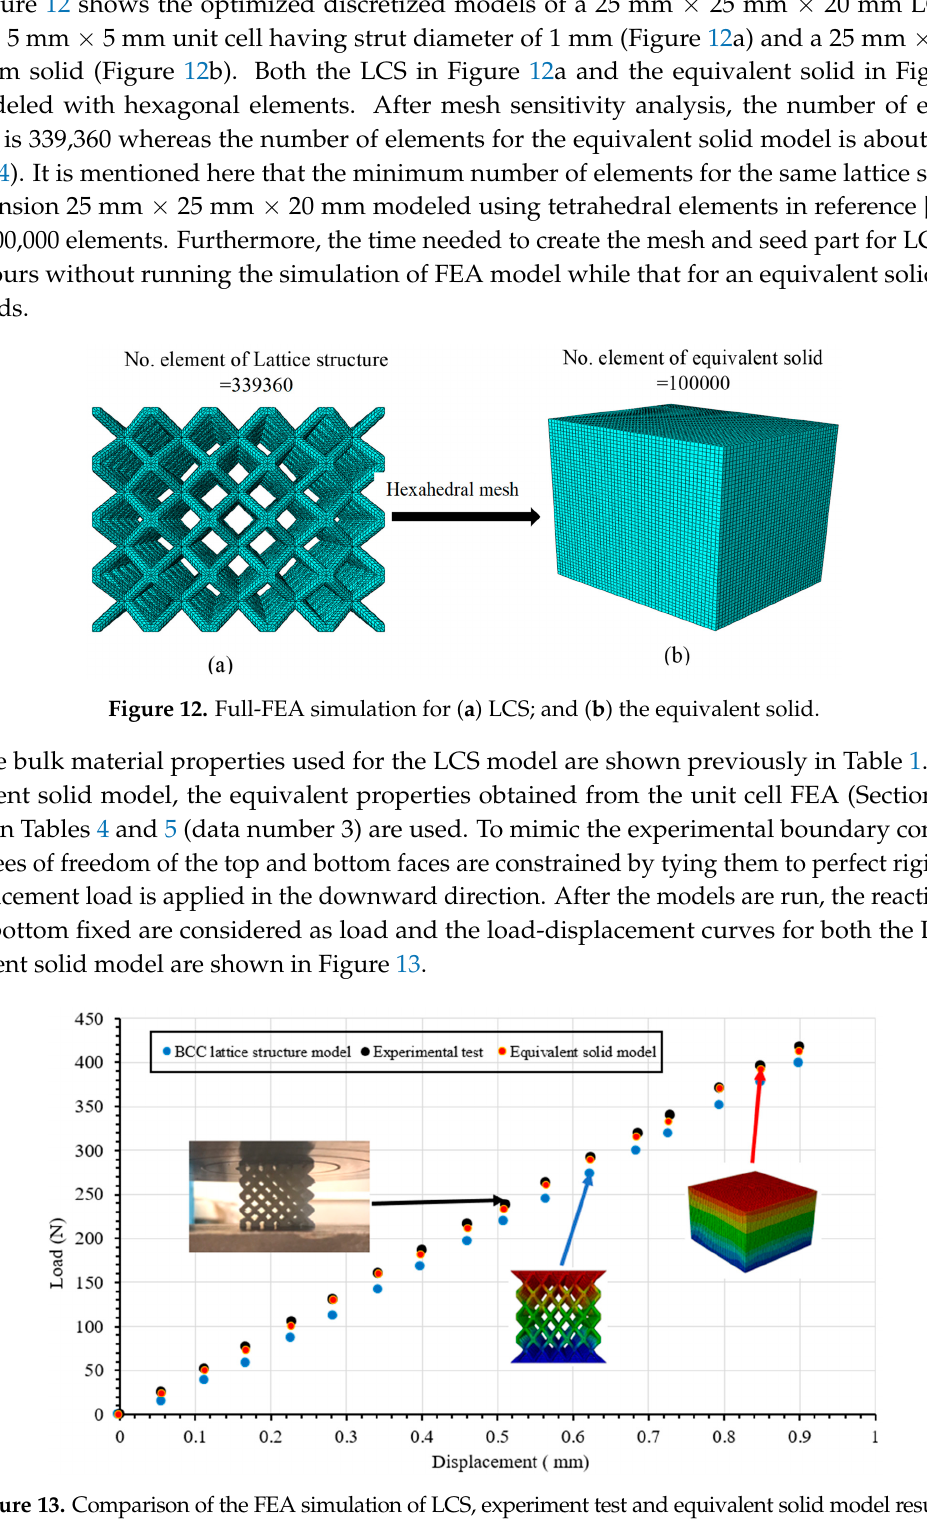
Figure 13. Comparison of the FEA simulation of LCS, experiment test and equivalent solid model results.